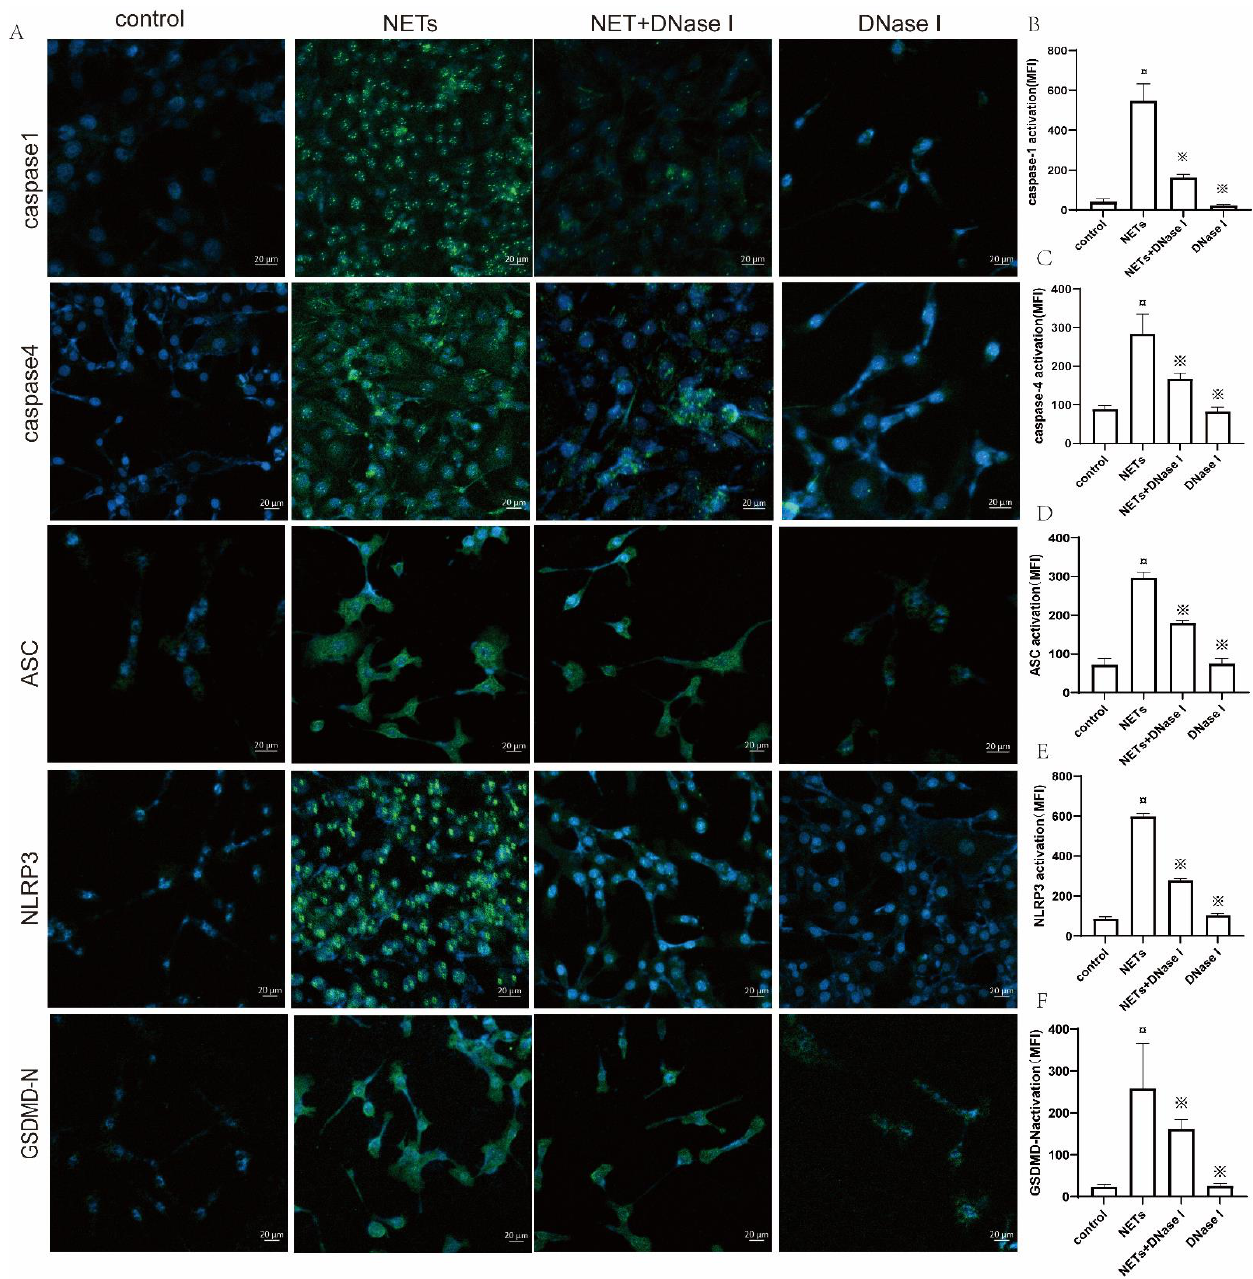
Figure 7. Representative immunofluorescent staining images for caspase-1, caspase-4, ASC, NLRP3, and GSDMD-N in untreated BEECs (control), NET-treated BEECs (NET), NET- and DNase I-treated BEECs (NET+ DNase I), and DNase I-treated BEECs (DNase I). ( A ) BEECs were subjected to immunofluorescent staining after treatment with NET (500 ng/mL), NET (500 ng/mL) + DNase I (25 µg/mL), or DNase I (25 µg/mL) for 16 h. The nuclei of BEECs were stained with DAPI (blue) and primary antibody (caspase-1, caspase-4, ASC, NLRP3, and GSDMD-N) conjugated with secondary antibody Alexa Fluor ®® 488 (green). ( B – F ) The mean fluorescence intensity (MFI) of activated ( B ) caspase-1, ( C ) caspase-4, ( D ) ASC, ( E ) NLRP3, and ( F ) GSDMD-N was detected and analyzed using confocal microscopy and an OLYMPUS Fluoview Ver.1.7c system. Values are presented as the mean ± SD ( n = 3). ¤ p < 0.05 vs. control group and ※ p < 0.05 vs. NETs without DNase I; white bar = 20 µm.